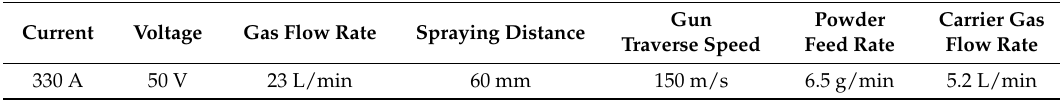
Table 1. Plasma spraying